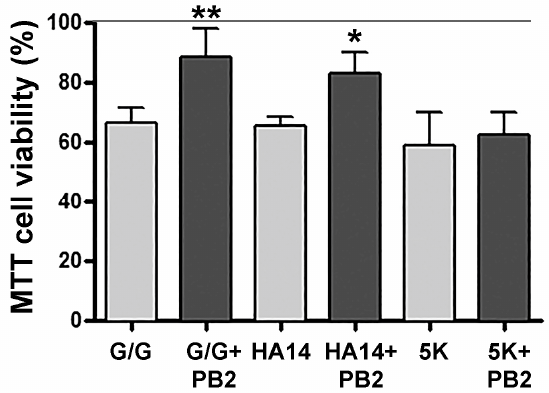
Figure 5. MTT viability assay to assess PB2 neuroprotection. CGNs were pre-incubated in 25K-serum control medium alone or containing 80 mM PB2, as described above, and then incubated for a further 24 h with either glutamate/glycine (G/G), HA14-1, or 5K apoptotic medium. Following incubation, an MTT viability assay was performed as described in Materials and Methods. The percentage viability is compared to cells incubated in control medium containing PB2 alone (100% line). The data represent the mean ± SEM viability for n = 4 independent experiments, each performed in duplicate. Data were analyzed by one-way ANOVA with a post hoc Tukey’s test. ** indicates p < 0.01 and * indicates p < 0.05 compared to each insult in the absence of PB2.